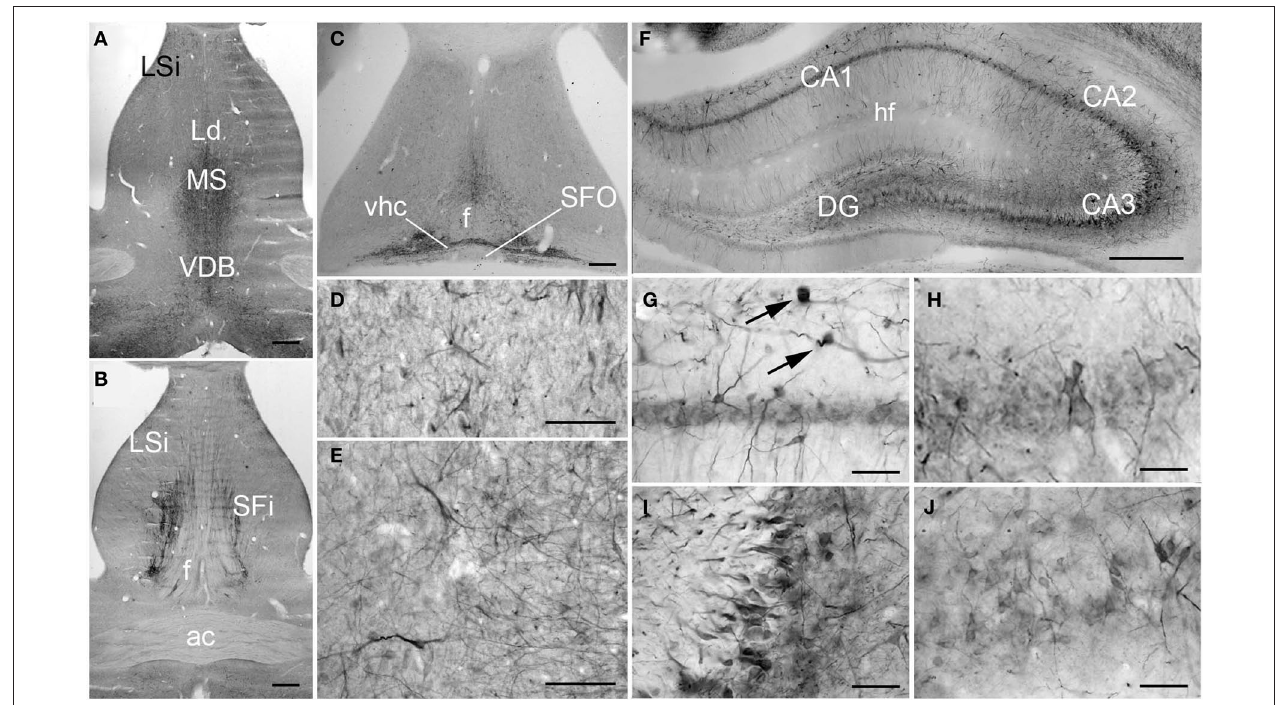
Figure 4 | PlexinA4 in septum and hippocampal formation. (A–C) Micrographs of coronal (A–B) and horizontal (C) sections immunostained for PlexinA4. PlexinA4 is visible in neurons and fibers in the medial septum (MS), the intermediate part of the lateral septal nuclei (LSi; D ), the vertical limb of the diagonal band (VDB; e ), the septofimbrial nuclei (SFi). PlexinA4 was also present in the ventral hippocampal commissure (vhc; C ). (F–J) Micrographs of coronal sections through the adult rat hippocampus stained for PlexinA4. PlexinA4 reaction product